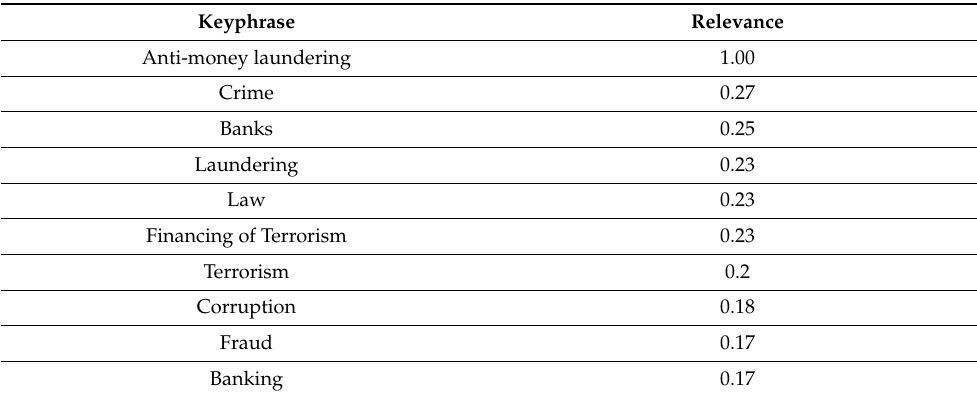
Table 12. Top ten relevance keyphrases, 2017 to 2021. Keyphrase